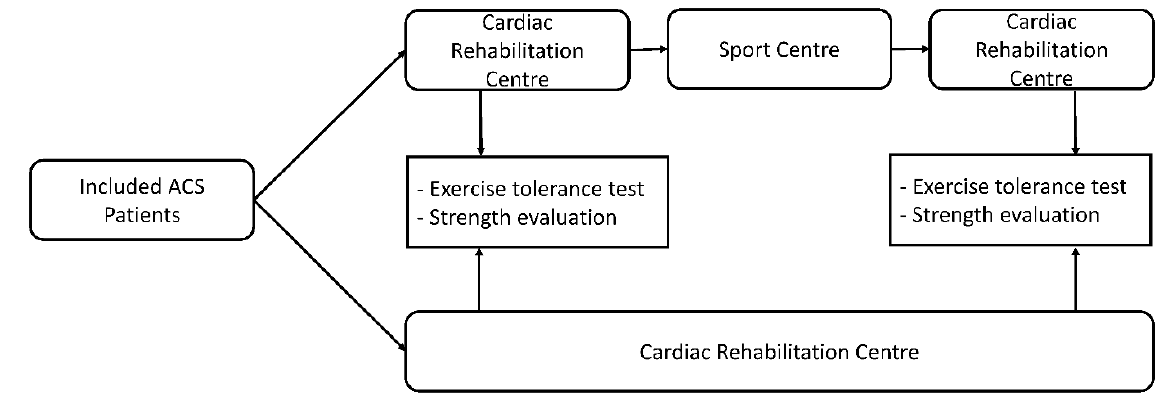
Figure 1. Design of the